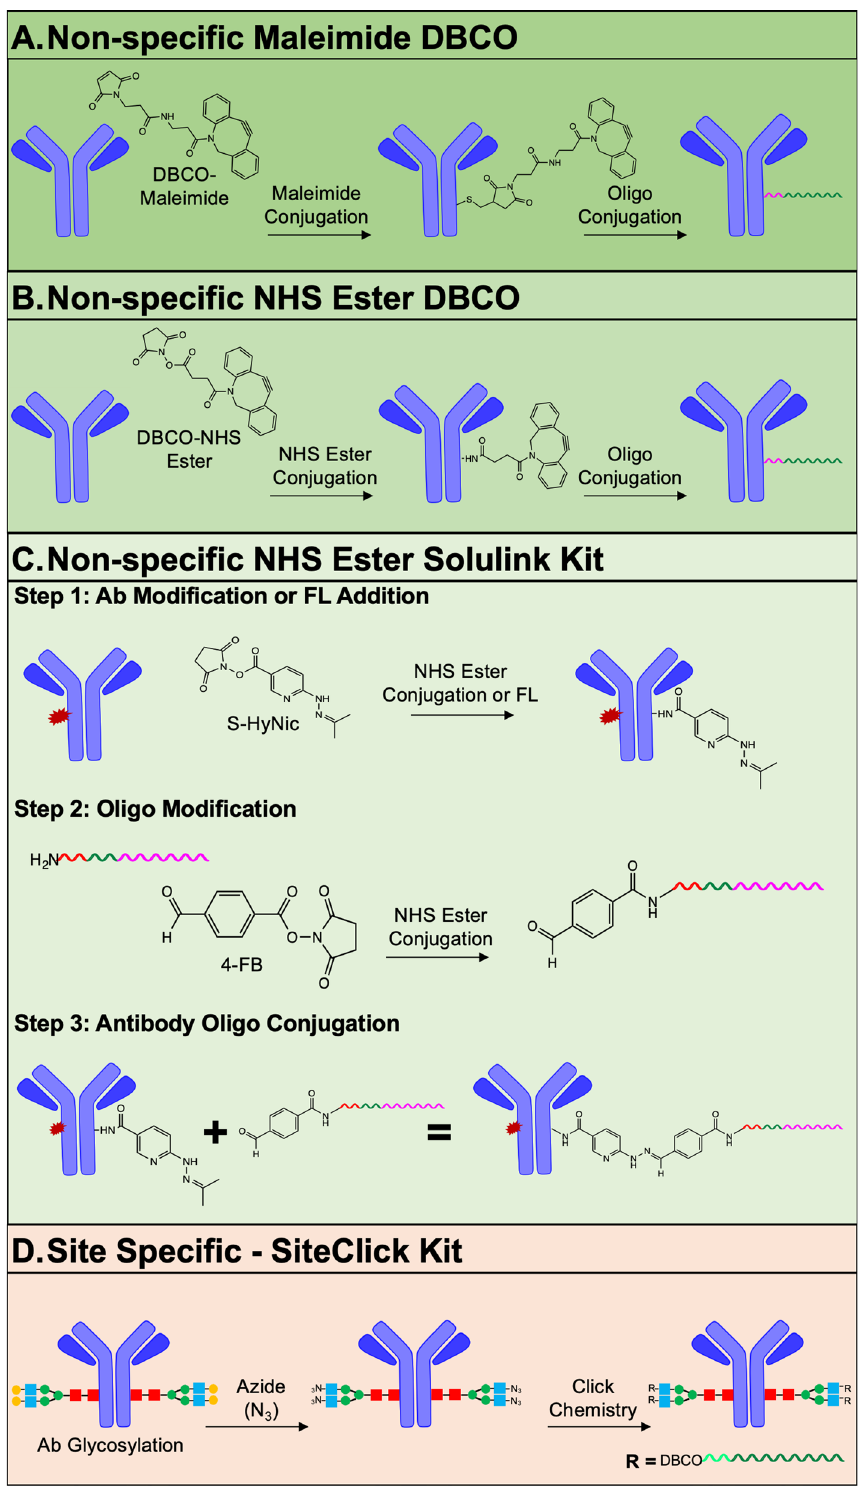
Figure 1. Antibody oligonucleotide (Ab-oligo) conjugation methods. Non-specific Ab-oligo conjugation methods were evaluated where ( A ) maleimide copper (Cu)-free click chemistry, ( B ) N-hydroxysuccinimide (NHS) ester Cu-free click chemistry and ( C ) NHS ester conjugation with the Solulink kit (Trilink Biotechnologies) were compared. To enable conjugation ratio quantification, cyanine 7 (Cy7, red explosion) was pre-conjugated to some antibodies prior to oligo labeling. ( D ) The site-specific SiteClick Kit (ThermoFisher Scientific) was also evaluated for oligo labeling utility, where modification was limited to the F c region of